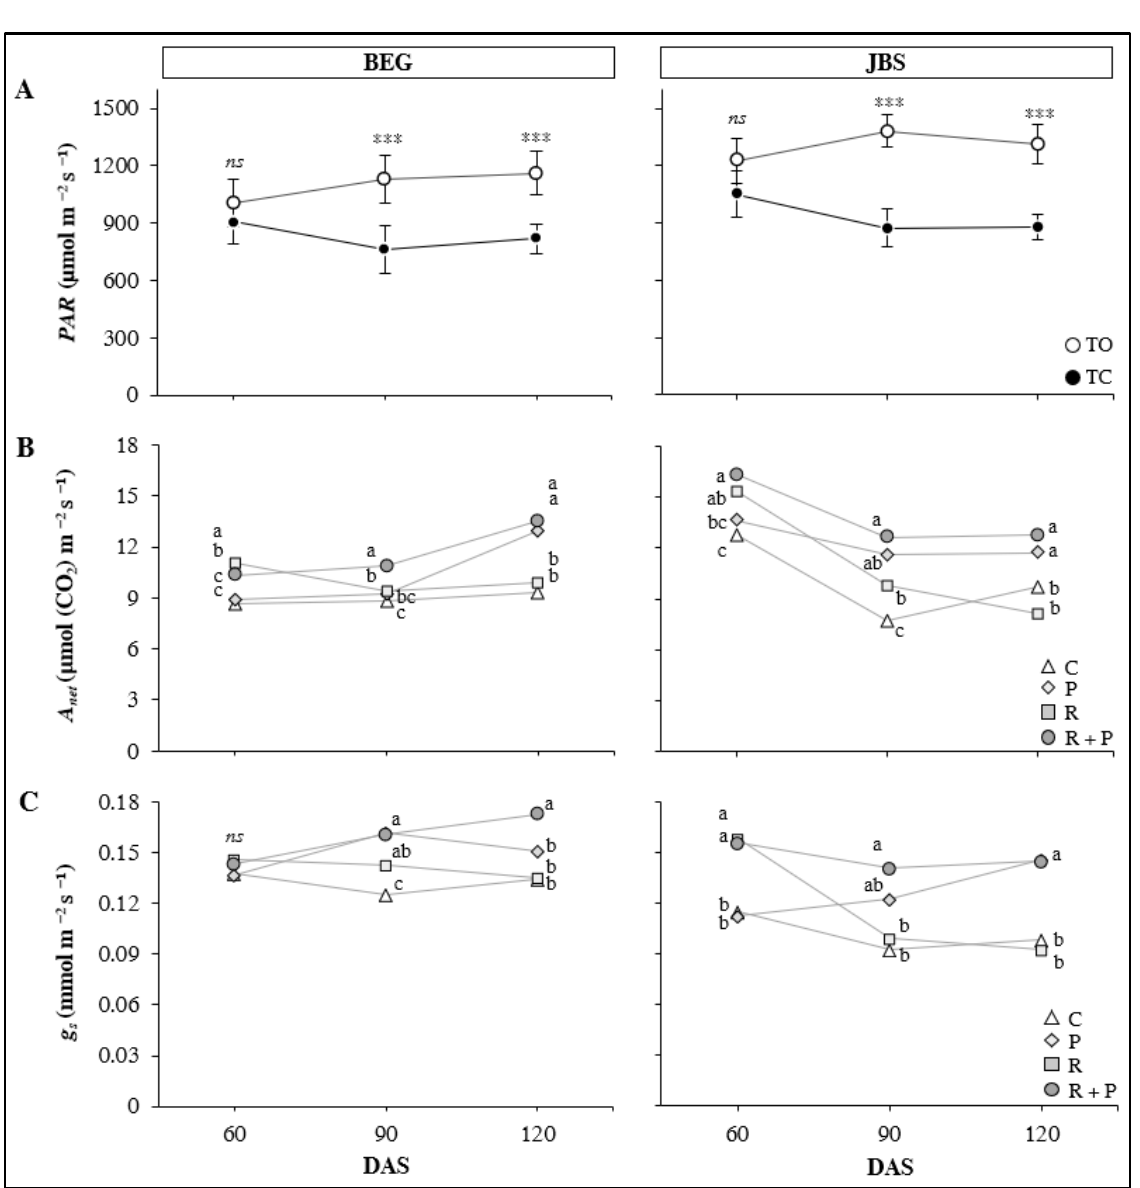
Figure 4. Photosynthetic active radiation (PAR) measured at the top of oat and clover intercrops and the effects of inoculation and co-inoculation with P. thivervalensis strain T124 and R. leguminosarum strain T618 on net photosynthetic rate (A net ) ( B ) and stomatal conductance (G s ) ( C ) of clover at BEG and JBS sites for the 2017 season. (Plot ( A ): TO, top of oat; TC, top of clover; ns, not significant, *** significant deference at p < 0.001; Plot ( B , C ): C, control un-inoculated, P: inoculated with P. thivervalensis strain T124; R: inoculated with R. leguminosarum strain T618; P + R: co-inoculated with T124 and T618 strains; treatments mean within each measurement date followed by different letters are significantly different ( p < 0.05)).